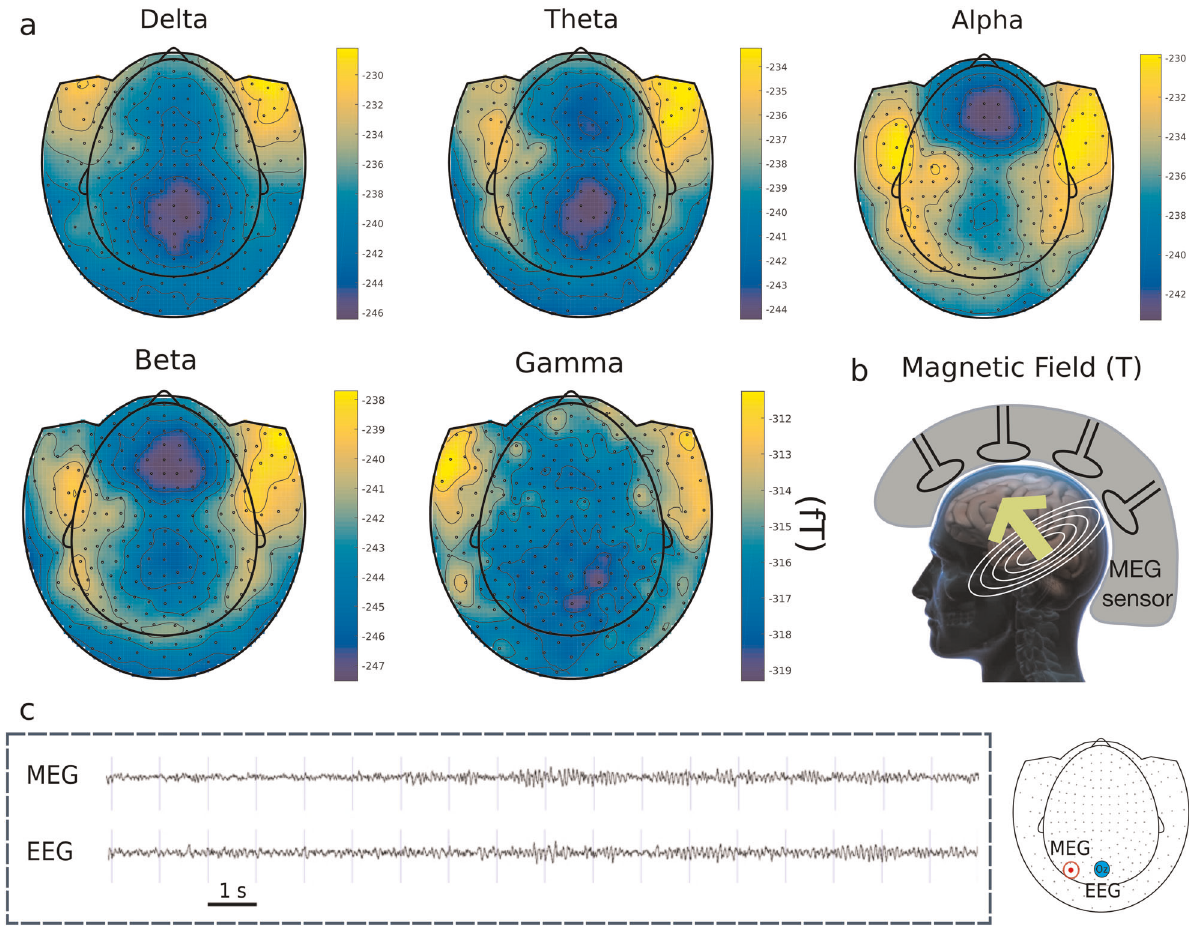
Fig. 4 Compatibility of TTE with magnetoencephalography (MEG). a MEG recording with TTEs on the head of the subject, depicted onto a head map. The signal is shown fractioned in the most known fi ve frequency windows: Delta (2 – 4 Hz), Theta (4 – 8 Hz), Alpha (8 – 12 Hz), Beta (12 – 30 Hz), Gamma (30 – 120 Hz). b Exempli fi cation of MEG sensors coupling with the human head. c Simultaneous MEG and EEG recordings with TTEs. On the right, the schematic representation of MEG sensor (right posterior location) and TTE (Oz location) from which two recoded signals are acquired. In both modalities, the presence of alpha waves appears after 8 electrodes placed on the phantom top surface. The inter-electrode distance between Ag/AgCl electrodes is fi xed at 33 mm correspond- ing to a 64 electrodes con fi guration on the head 63 . On the other hand, TTEs are placed at 20 mm center-to-center distance in order to double the density of electrodes with respect to the Ag/AgCl case. In our experiments, the output signals are acquired in bipolar mode, from the pair of Ag/AgCl electrodes and from the two pairs of TTEs. The recorded signals (Fig. 5c) show that with two pairs of TTEs it is possible to identify the input source by analyzing the amplitude variation of the recorded signals. Indeed, it is clearly visible how the right couple of TTEs (the red signal in Fig. 5c), that is located near the peak signal source, are able to detect higher intensity signal. The amplitude of the peak recorded with the right TTEs is of the same order of magnitude than with the Ag/AgCl (the blue signal in Fig. 5c). The peak amplitude is equal to 7.6 mV in the left TTEs, 13.9 mV in the right TTEs, and 25 mV in the Ag/AgCl electrodes. The higher amplitude in Ag/AgCl recordings is explained by the bigger surface coverage with these electrodes, which includes the location of all four stimulating electrodes underneath. Notably, the sensitivity to the square wave stimula- tion of the left pair of TTEs is well apparent. Indeed, the left pair of TTEs (the purple signal in Fig. 5c), which is closer to the square wave signal, showed a more marked response to this wave, when it propagated through the RC module of the phantom. Ag/AgCl